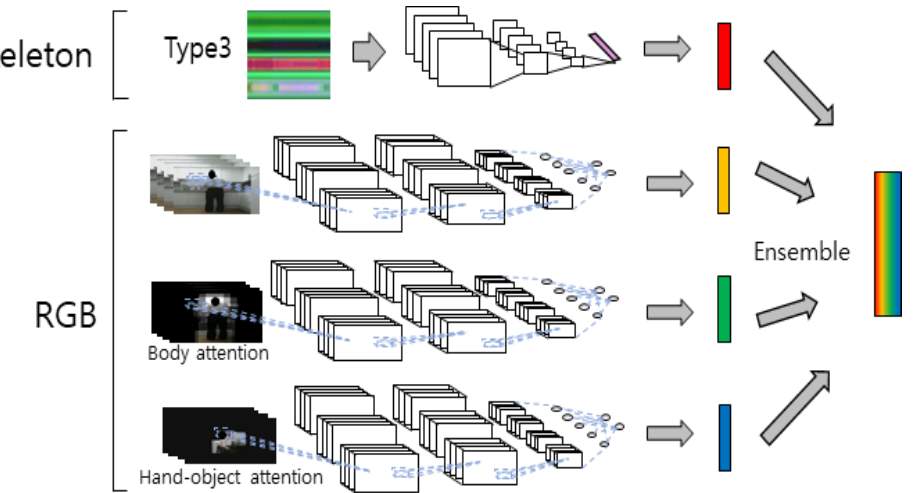
Figure 13. Diagram of ROI-based four-stream ensemble model for behavior recognition.